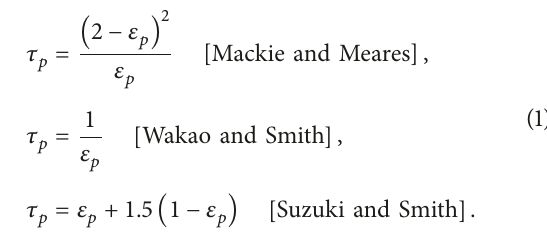
(a) Specific gravity of crude oil (sour blend): 0.842. (b) Dynamic viscosity: 34.8 × 10 −3 Pa ⋅ s. (c) Approximately apparent diffusivity of oil sample: 1.018 × 10 −3 cm 2